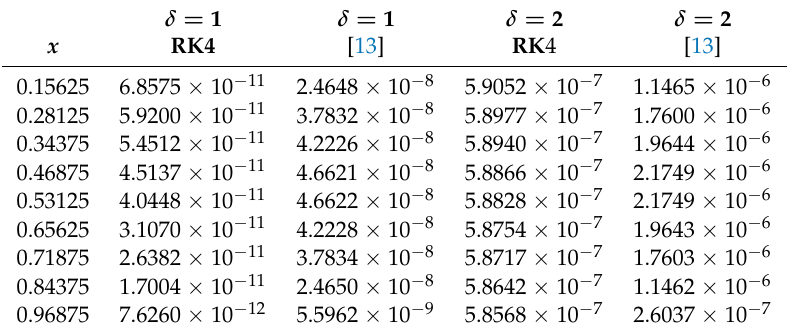
Table 4. Comparisons between the results obtained by the LMM with those adapted from [13] in term of L abs error norm for Test Problem